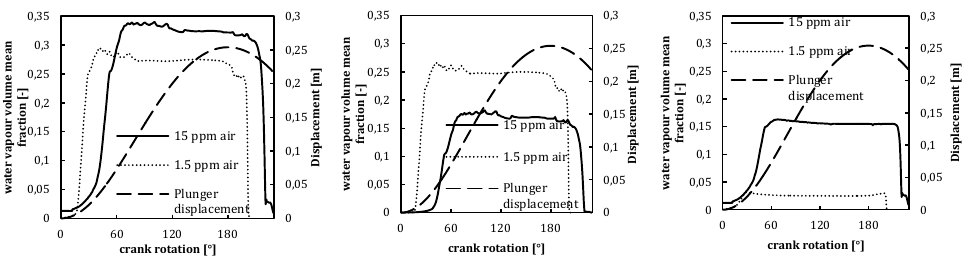
Figure 6: (Left) 2nd phase (water + air) volume fraction in the valve-seat lift volume when the air mass fraction is 15 and 1.5 ppm. (middle) Overall amount of vapour volume fraction. (right) overall amount of air volume fraction.